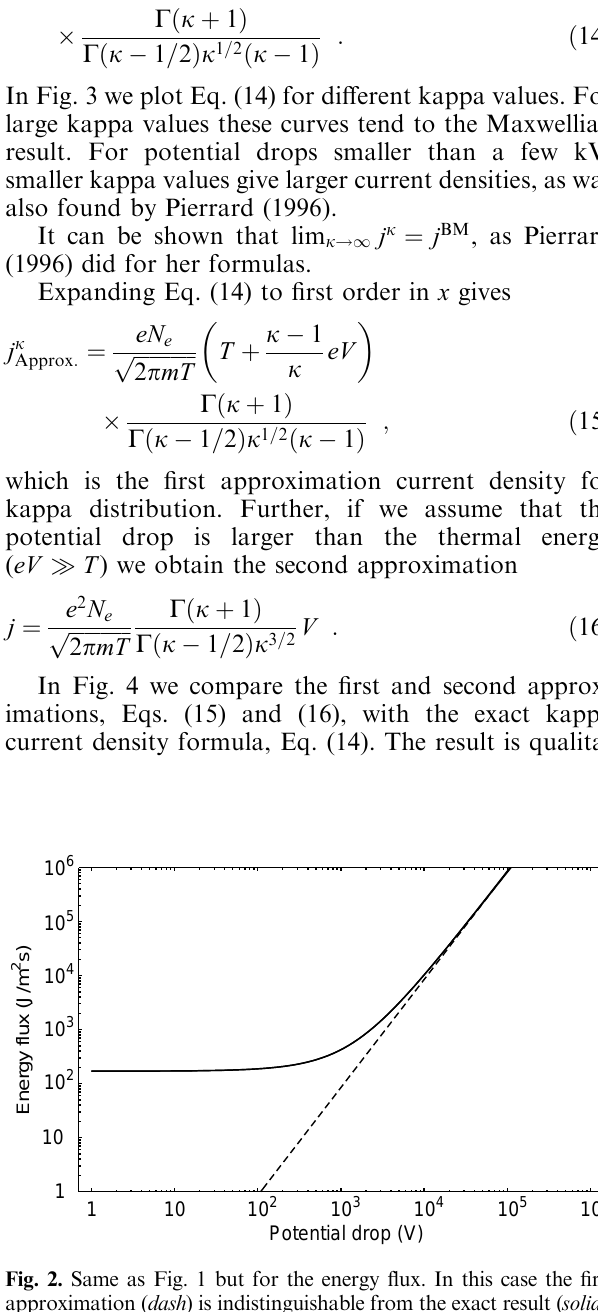
Fig. 4. Same as Fig. 1 but for the kappa distribution ( (cid:106) (cid:136) 4). The overlapping of the curves is similar to